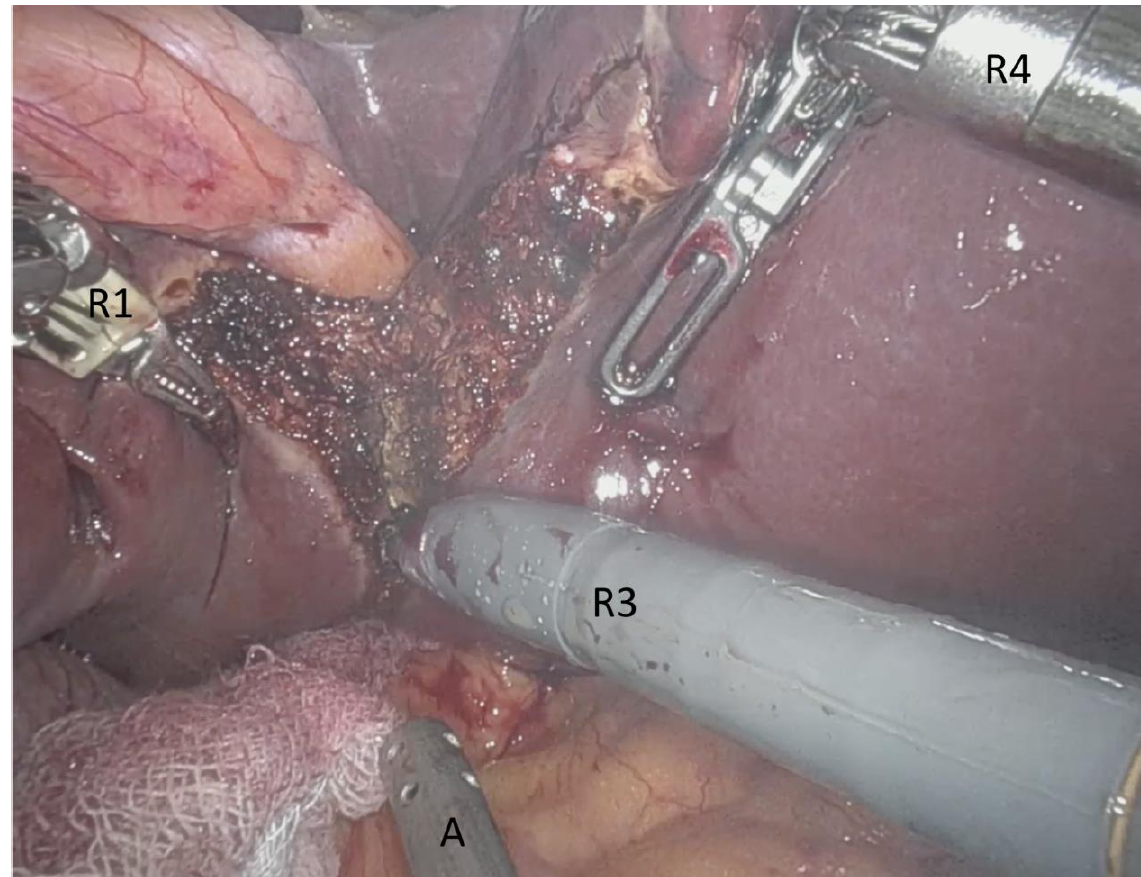
Figure 2. Intraoperative view from the console during robotic-assisted liver resection (DaVinci Xi System, Intuitive Surgical, Inc., Sunnyvale, CA, USA). R1: Robotic arm 1 with bipolar Maryland forceps, A: Laparoscopic instrument (sugger) driven by the assistant from the table, R3: Robotic arm 3 with monopolar scissors, R4: Robotic arm 4 with fenestrated grasps as retraction device.